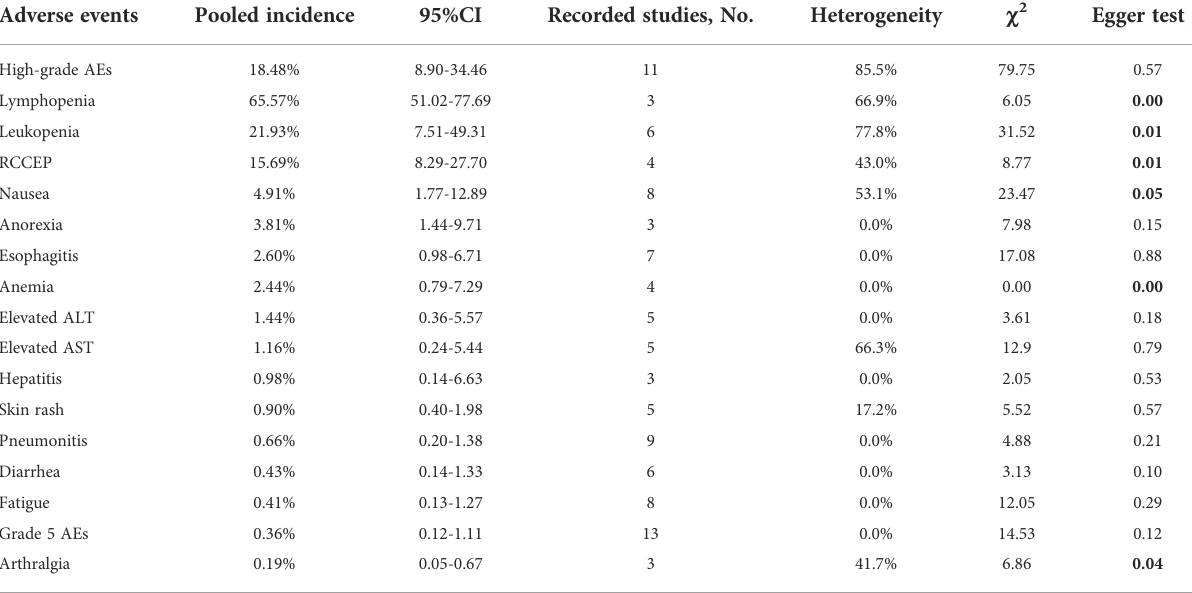
TABLE 2 Incidences of high-grade AEs recorded by at least three